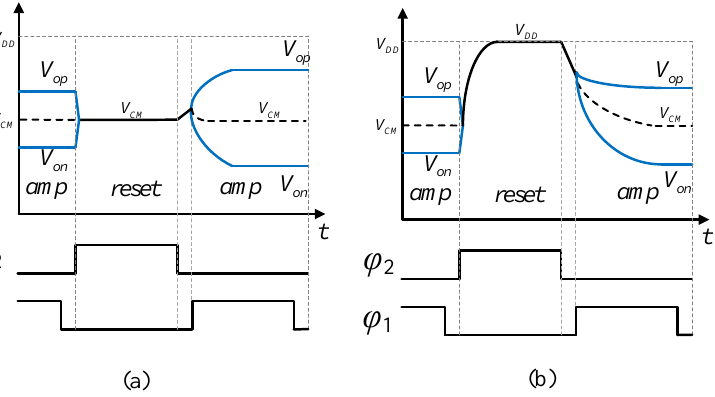
Figure 8. ( a ) Proposed dynamic amplifier timing and output voltage variation. ( b ) The associated CM voltage drop effects proposed in